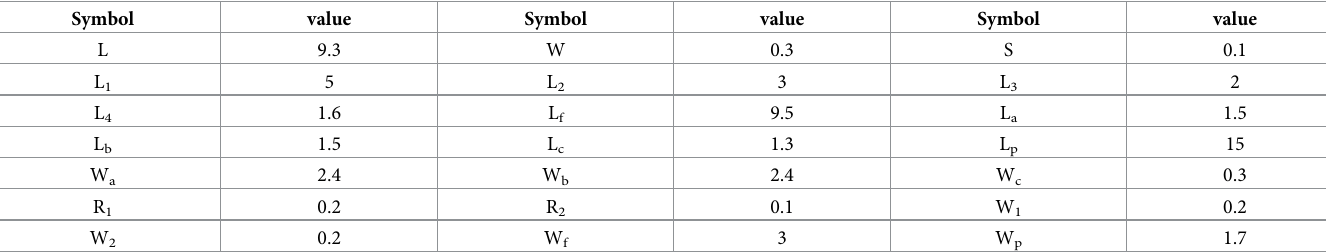
Table 2. UWB triple notch filter physical parameters in millimetre